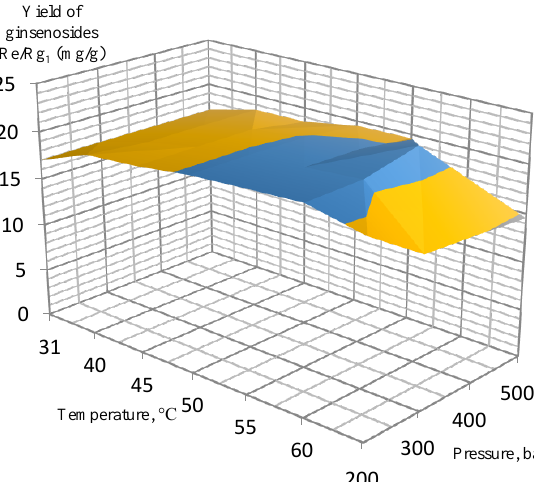
Figure 4. Orthogonal projection representing the results of extraction of ginsenosides Re and Rg 1 at 200 to 500 bar and 3.4% EtOH co-solvent.